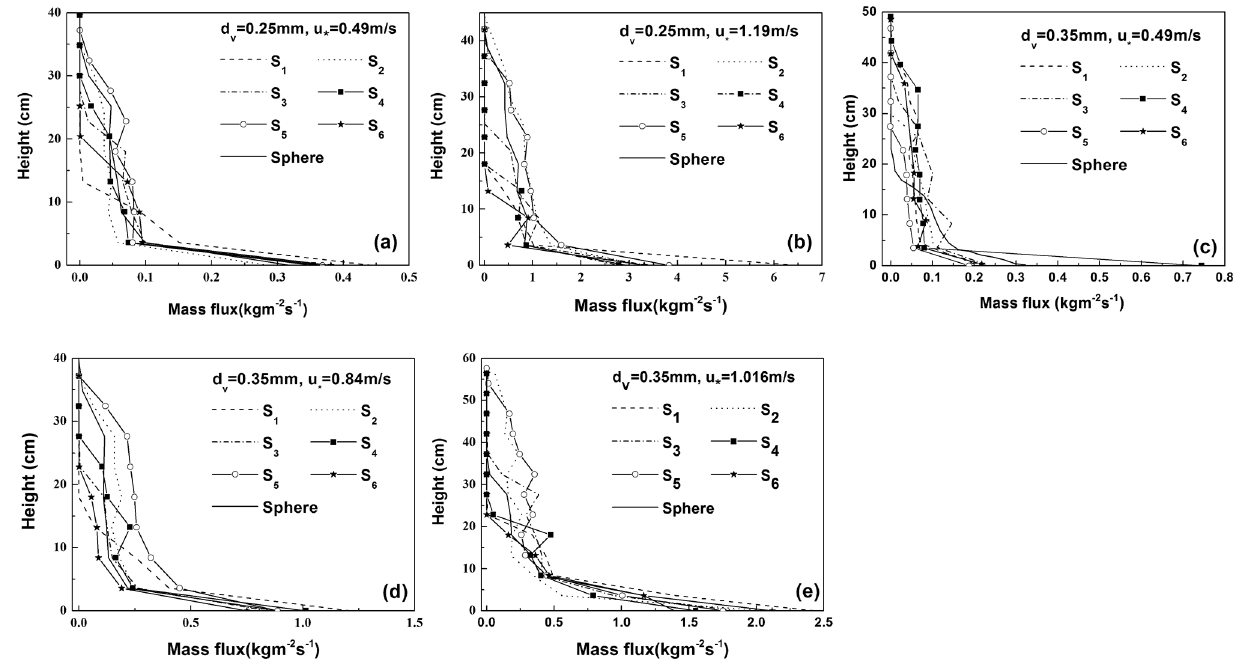
Figure 5. The sand transport rates of sand particles with different shapes as a function of height. (a) and (b) show the sand transport rates of sand particles with the same equivalent diameter of d v ~ 0 : 25 mm as a function of height but at different friction wind velocities. (c), (d) and (e) represent the sand transport rates of sand particles with the same equivalent diameter of d v ~ 0 : 35 mm as a function of height but at different friction wind velocities. Here, the black solid line indicates the spherical sand grains, S 1 and S 2 are two different ellipsoid-shaped sand particles, S 3 represents cube-shaped sand particles, S 4 and S 5 are two types of cylinder-shaped sand particles, and S 6 represents frustum-shaped sand particles.